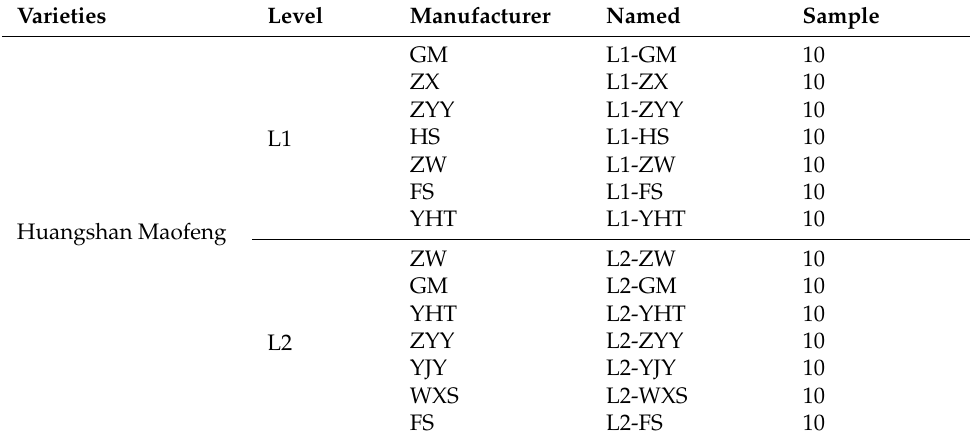
Table 1. Statistics of green tea samples. Varieties Level